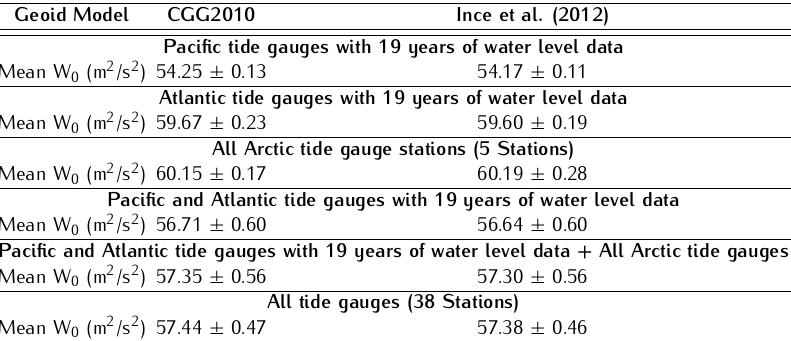
Table 3. W 0 values for three Canadian regions computed with regional gravimetric geoid models (add 62636800.00 m 2 /s 2 to all